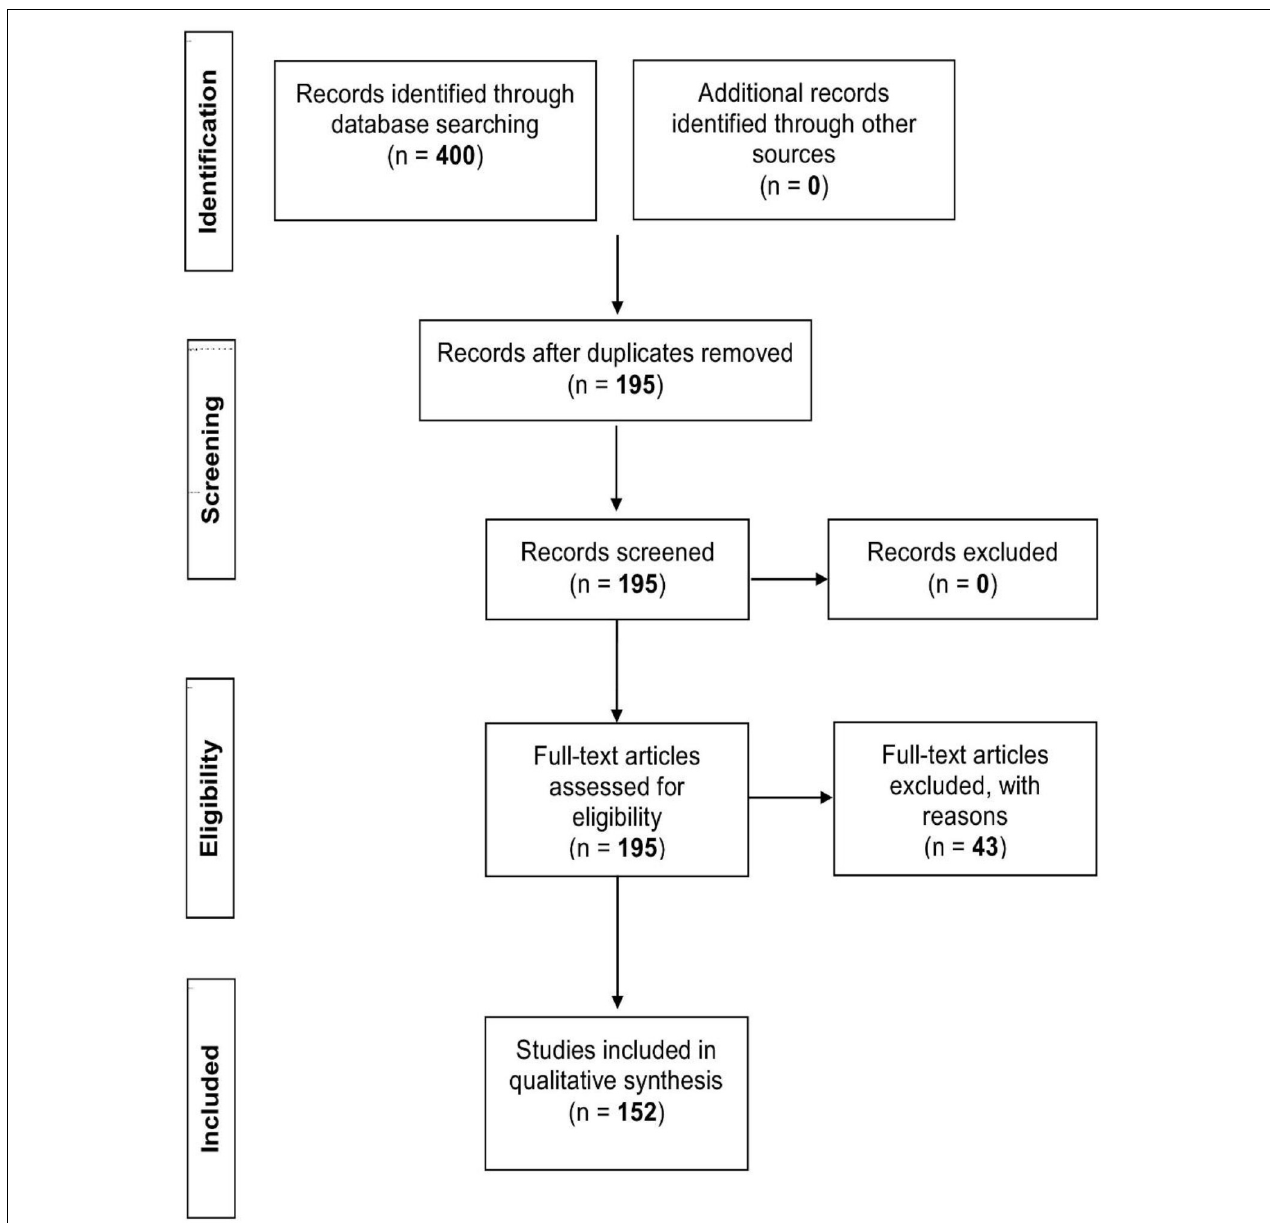
FIGURE 1 | PRISMA flow